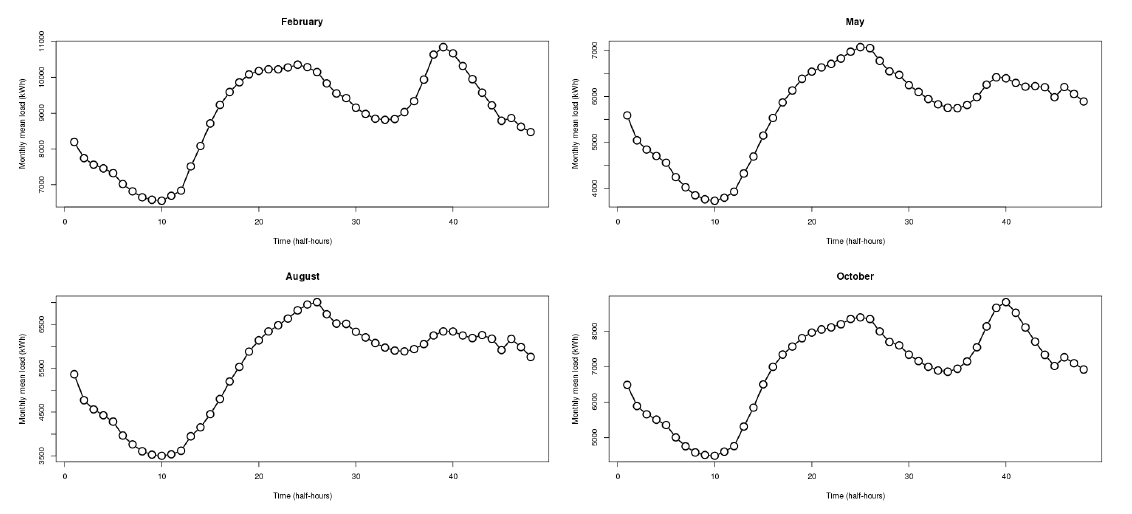
Figure 6. Monthly mean of daily load for four months: February, May, August and